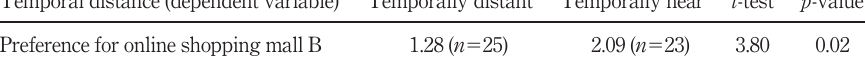
Figure 1. Preference for online shopping mall